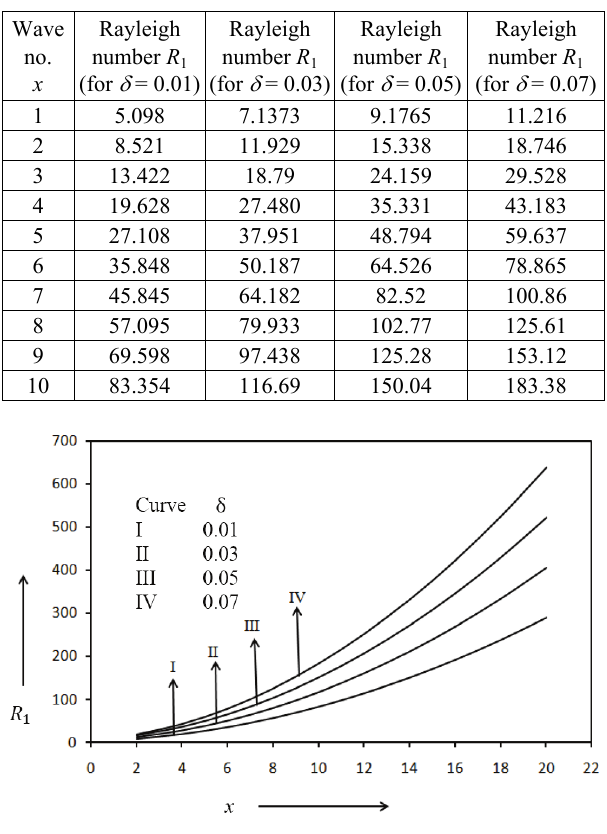
Fig. 2. Variation of Rayleigh number ( R 1 ), with wave number ( x ) for M 1 = 1, M 3 = 25,  = 0.01, 0.03, 0.05 and 0.07 for curves I, II, III and IV,